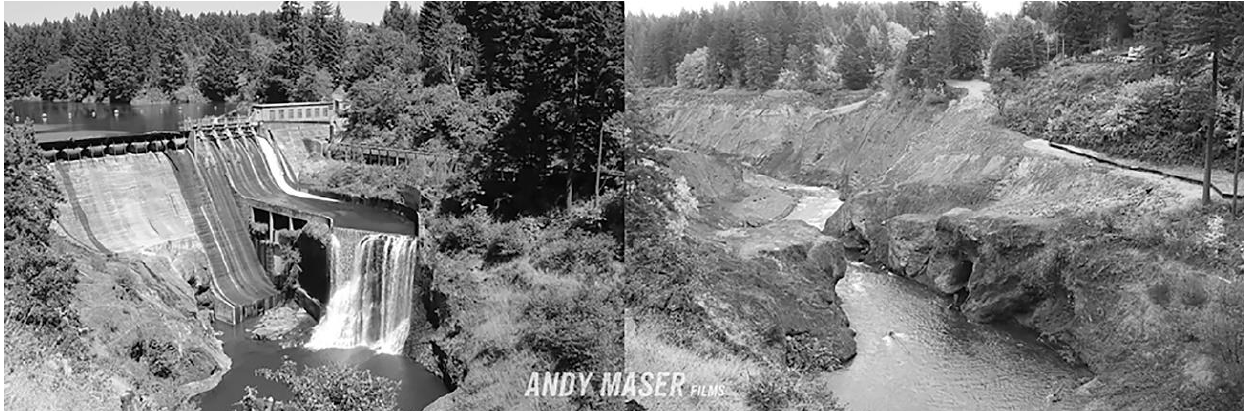
Figure 10. Condit Dam before and after the removal